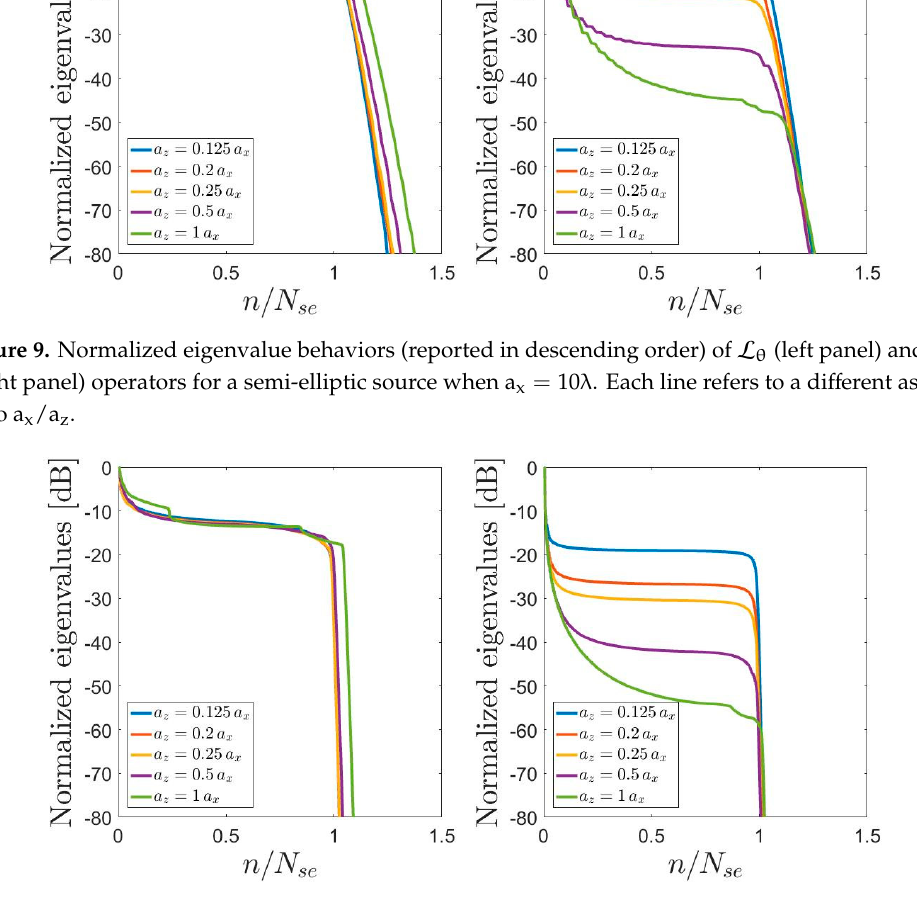
Figure 10. Normalized eigenvalue behaviors (reported in descending order) of L θ (left panel) and L u (right panel) operators for a semi-elliptic source when a x = 100 λ . Each line refers to a di ff erent aspect ratio a x /a z .